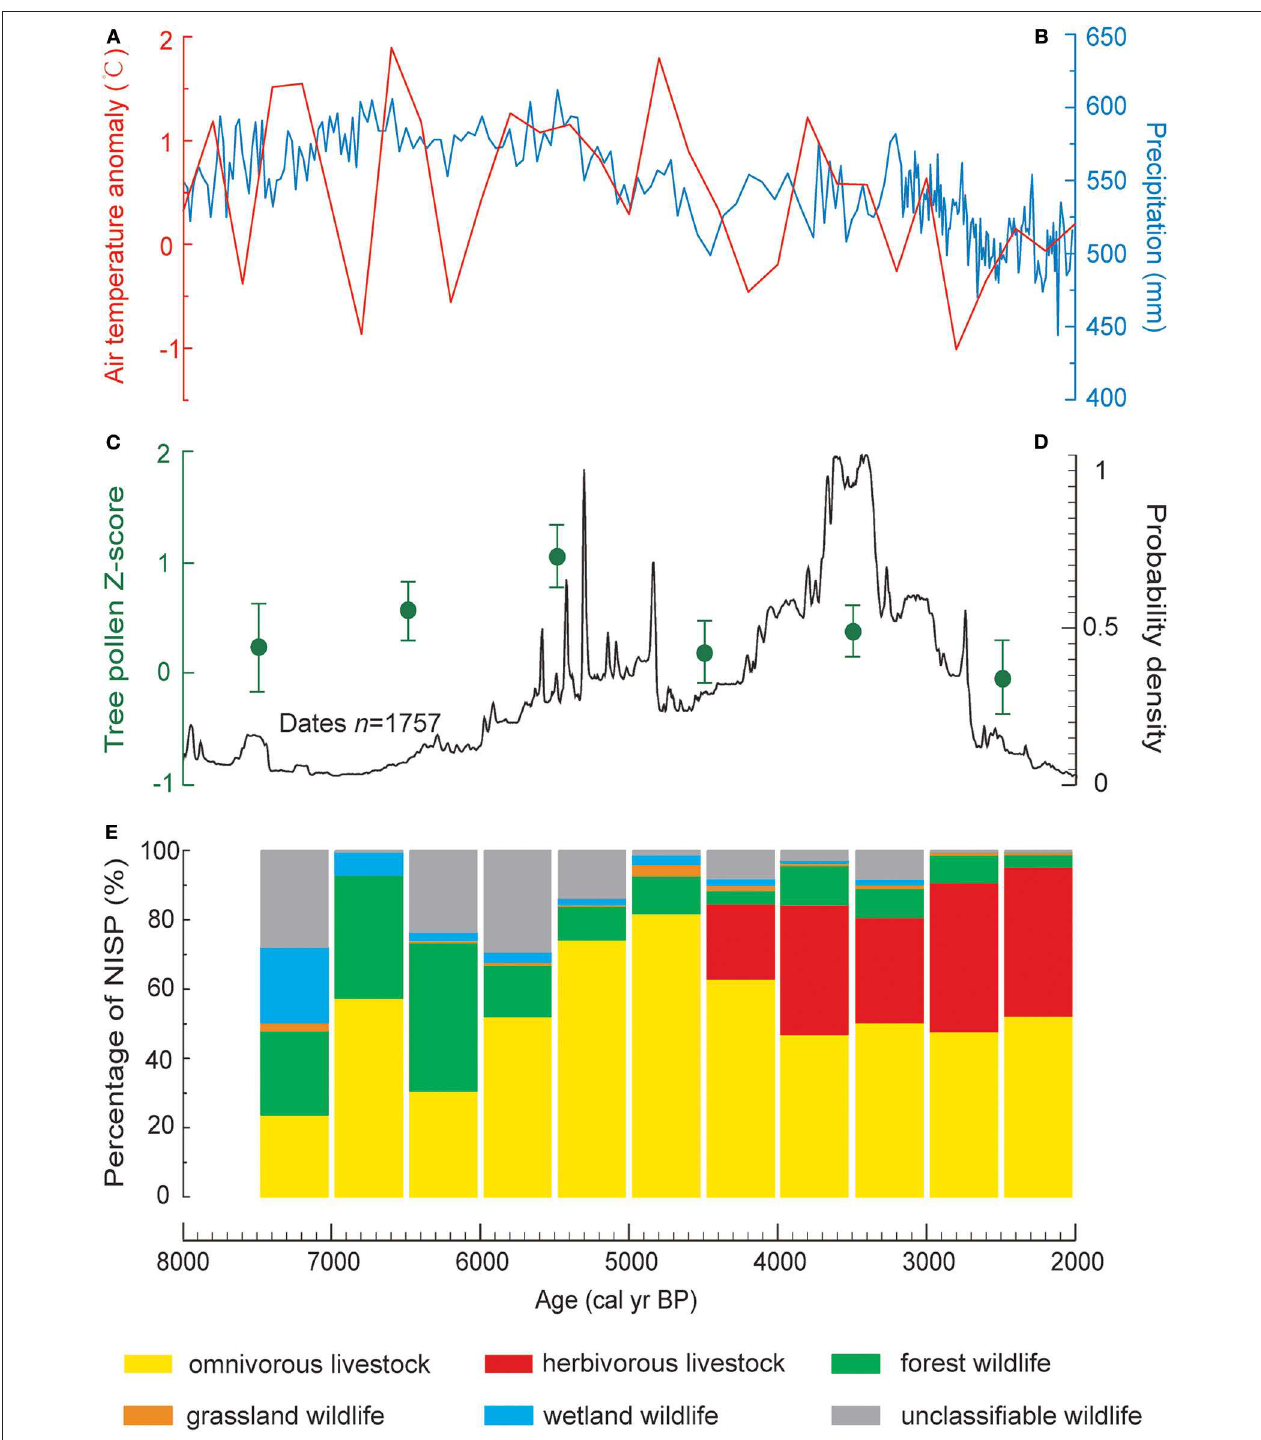
FIGURE 3 | Variation in the NISP (Number of Identified Specimen) percentages of faunal remains representing different habitats, compared with climate and vegetation changes, and the summed probability distribution of original radiocarbon dates from 8000 to 2000 BP. (A) North China temperature record (Hou and Fang, 2012). (B) Pollen-based annual precipitation regime, reconstructed from Gonghai Lake (Chen et al., 2015b). (C) Synthesized standard curve of tree pollen percentages in the monsoon margin region (lying between forest and steppe) (Zhao and Yu, 2012). (D) Summed probability distribution of original radiocarbon dates from 8000 to 2000 BP, revealing the trends and fluctuations in human population (Dong et al., 2019). (E) NISP percentage of livestock remains and wild mammal remains representing different habitats.